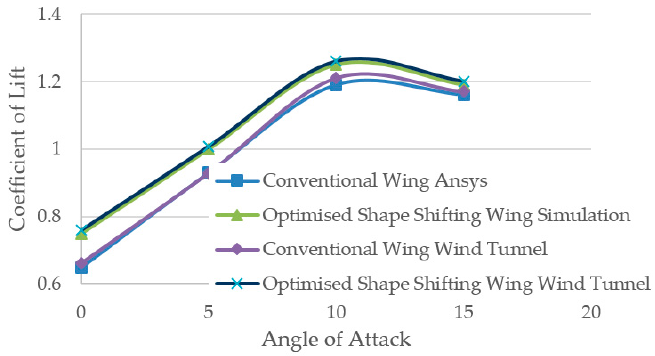
Figure 27. A graph showing coefficients of lift for Ansys simulation and wind tunnel testing.